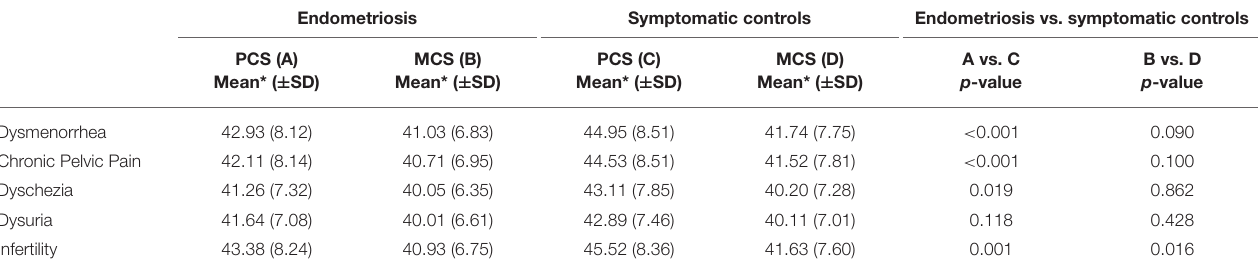
TABLE 3 | Association between endometriosis symptomatology and SF-36 composite scores for endometriosis cases and symptomatic controls. Endometriosis